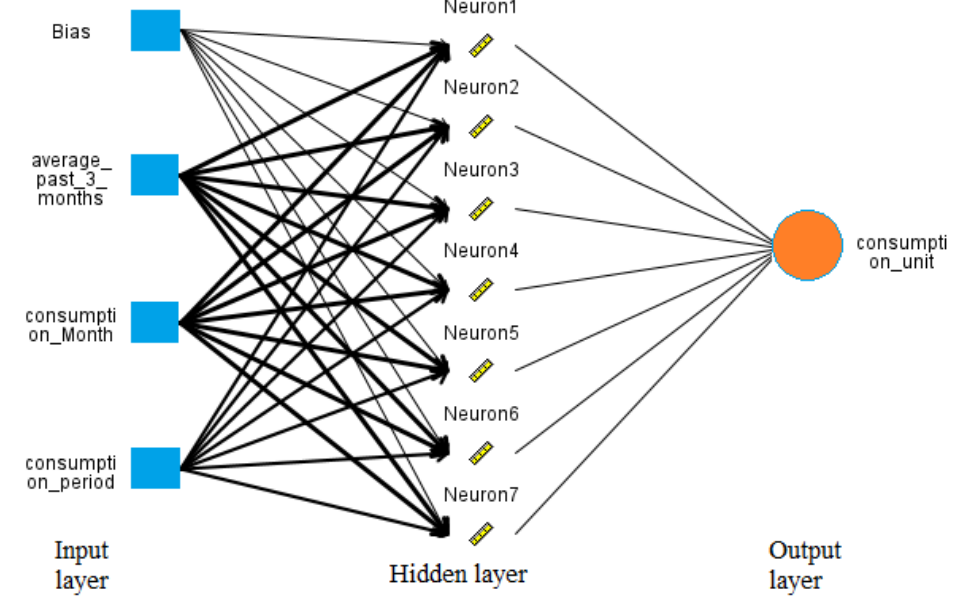
Figure 3. Structure of an ANN model with one hidden layer and seven